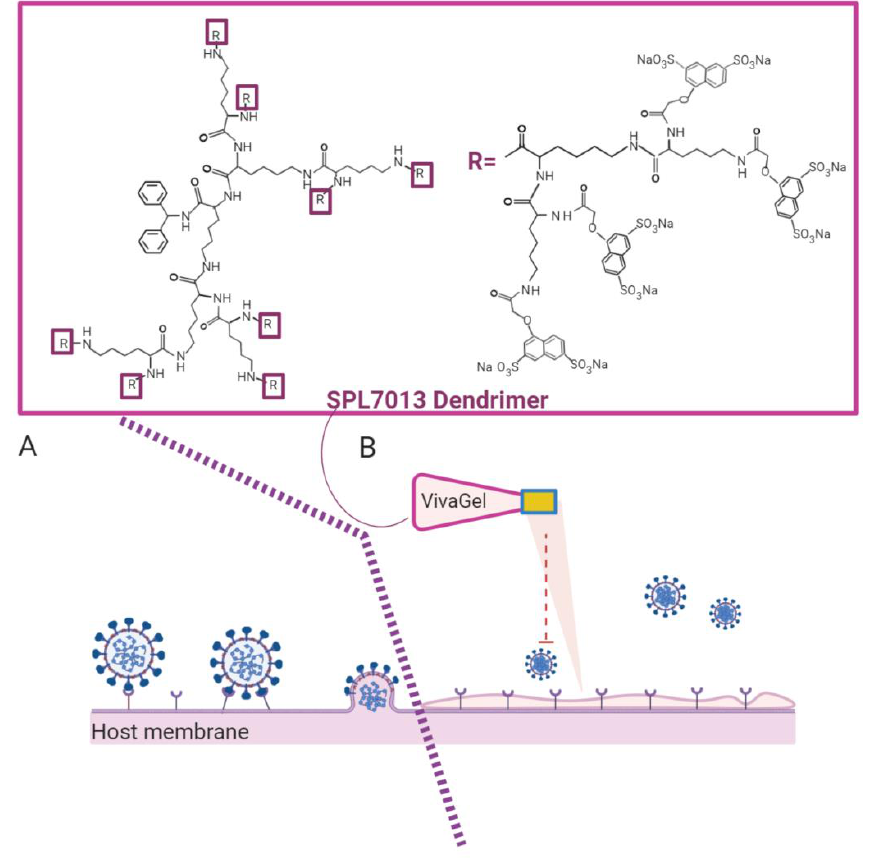
Figure 6. Representation of the SPL7013 dendrimer (VivaGel ® ) mechanism. ( A ) The host cell infected by the virus. ( B ) The host is protected from the infection by treatment with VivaGel ® , which prevents the interaction and fusion of the virus with the host-cell membrane. Created with BioRender.com .